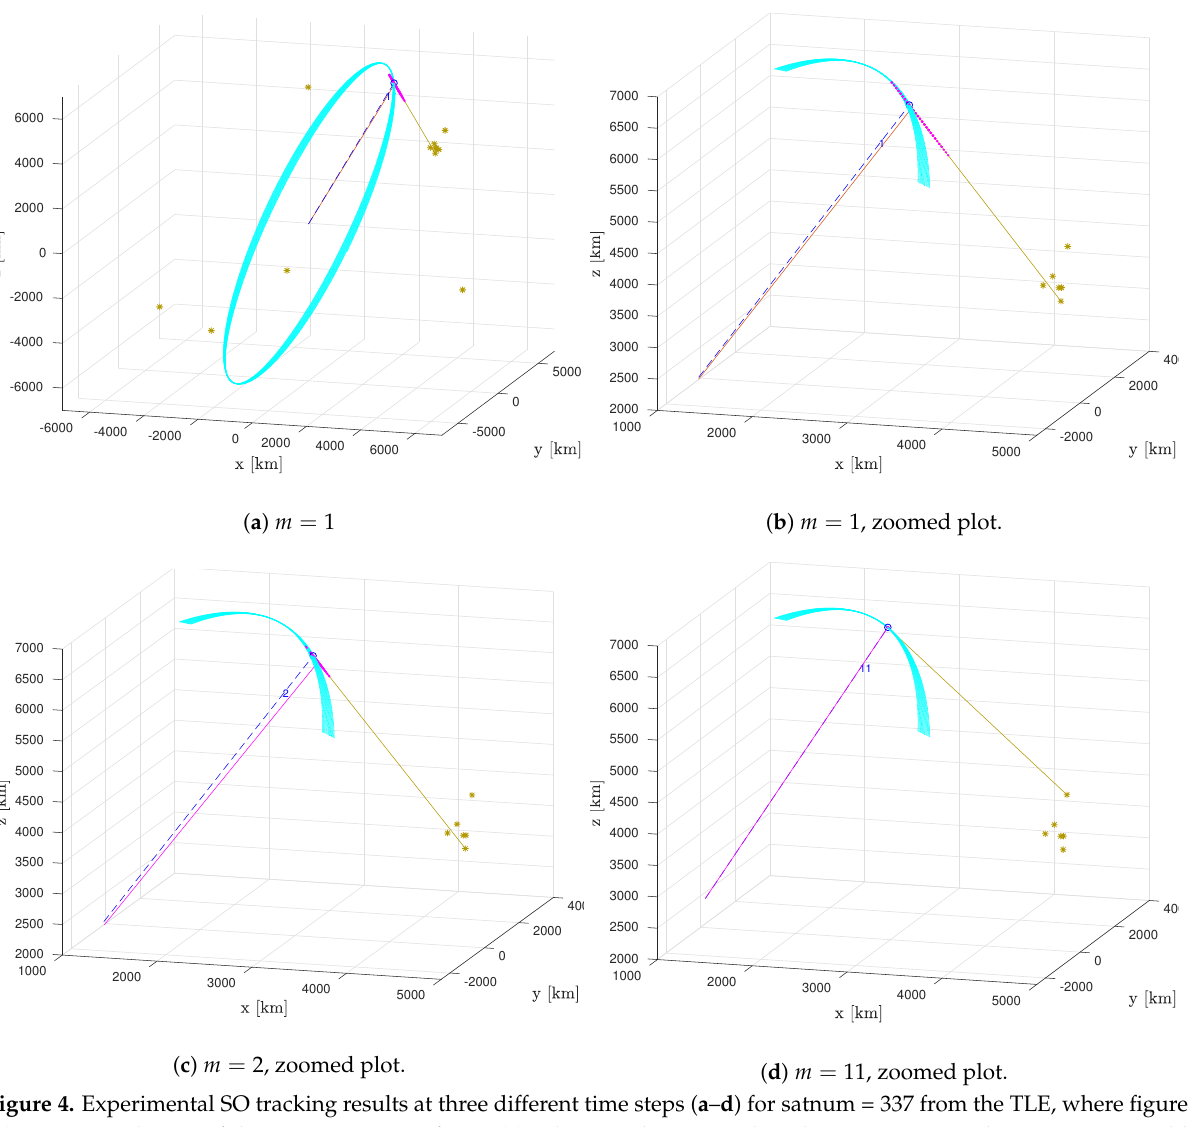
( c ) m = 2, zoomed plot. ( d ) m = 11, zoomed plot. Figure 4. Experimental SO tracking results at three different time steps ( a – d ) for satnum = 337 from the TLE, where figure ( b ) is a zoomed view of the SO trajectory in figure ( a ). The complete ground truth trajectories are shown in cyan. Gold stars ( ∗ ) represent the telescope positions. Circles show the ground truth SO location and their neighboring numbers m correspond to the m th measurement update. The pink points show the SO’s